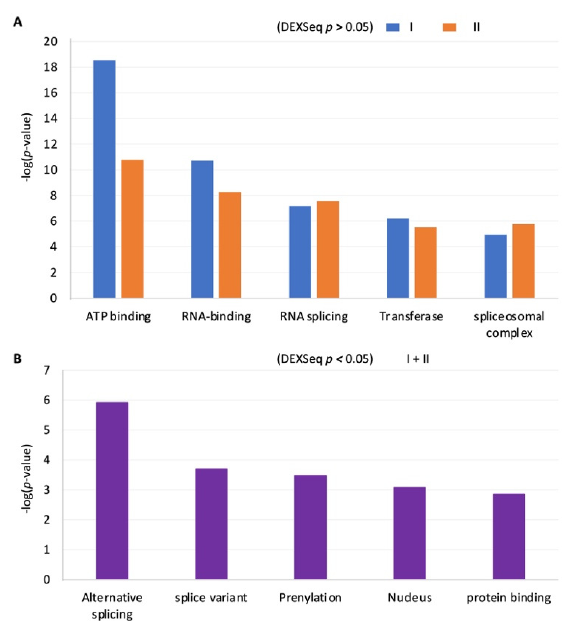
Figure 7. Significantly enriched functional clusters of the genes identified with RISE. Bar graphs of the –LOG ( p -value) of the DAVID functional clustering analysis for genes with type I or II RISE pairing of adjacent exons without significant changes by depolarization (( A ), p < 0.05 by DEXSeq, n = 663 and 456 gene IDs for type I and II, respectively) and those with adjacent exons changed significantly by depolarization (( B ), p < 0.05 by DEXSeq, n = 34 gene IDs).